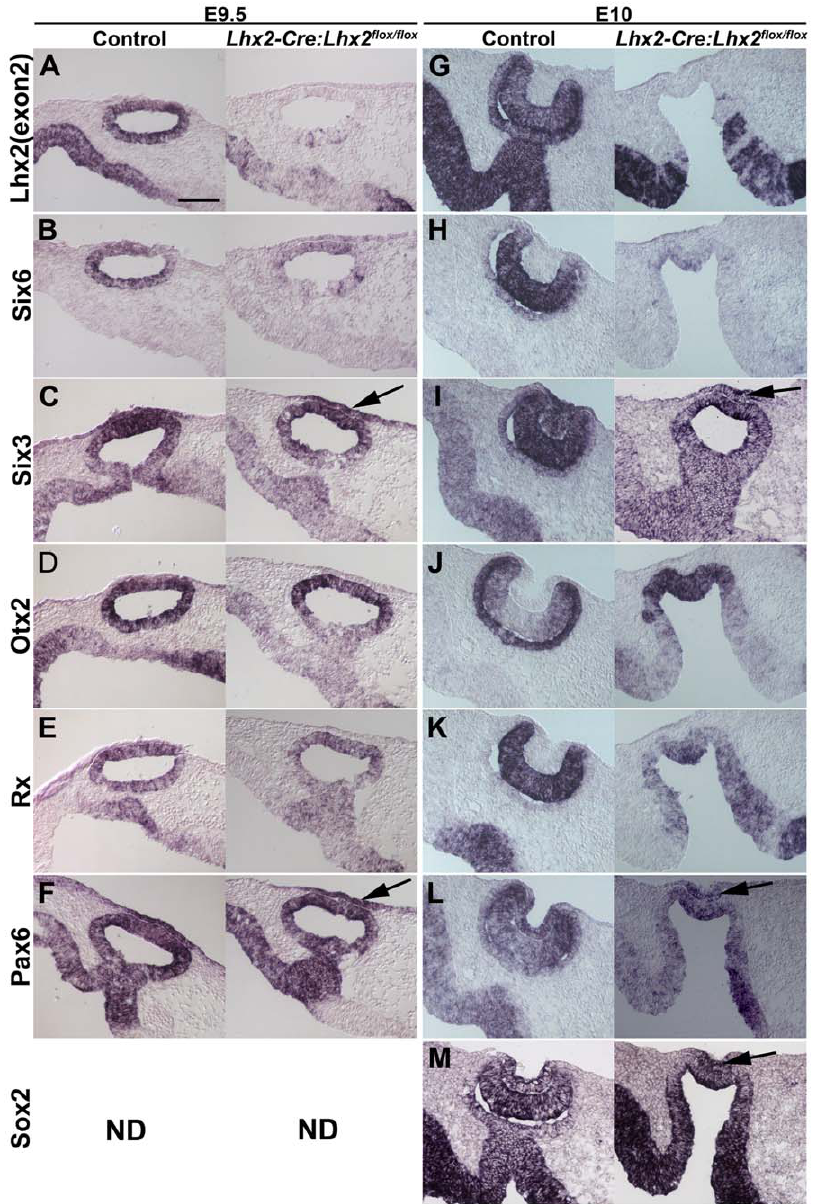
Figure 4. The optic vesicle and the lens placode develop further in the conditional mutant compared with conventional mutant. Gene expression is analysed in optic vesicles in transversal sections at E9.5 (A–F) in control embryos (left panels) and in the conditional mutants ( Lhx2- Cre:Lhx2 flox/flox ) (right panels). Gene expression is analysed in optic cups on transversal sections at E10 (G–M) in control embryos (left panels) and in the conditional mutants (right panels). In situ hybridisation analyses to detect exon 2 (exon2) of the Lhx2 gene to reveal the domain in the optic vesicle where the Lhx2 gene has been inactivated in the conditional mutant at E9.5 (A) and at E10 (G). In situ hybridisation to analyse expression of: Six6 in the control and conditional mutant at E9.5 (B) and at E10 (H), Six3 in the control and conditional mutant at E9.5 (C) and at E10 (I), Otx2 in the control and conditional mutant at E9.5 (D) and at E10 (J), Rx in the control and conditional mutant at E9.5 (E) and at E10 (K), Pax6 in the control and conditional mutant at E9.5 (F) and at E10 (L), and Sox2 in the control and conditional mutant at E10 (M). Six6 expression is down-regulated both at E9.5 (B) and E10 (H). The thickening of the surface ectoderm acquires some molecular characteristics of the lens placode as determined by expression of Six3 (arrows, C and I), Pax6 (arrows, F and L) and Sox2 (arrows, M). ND, not done. Scale bar: 100 m